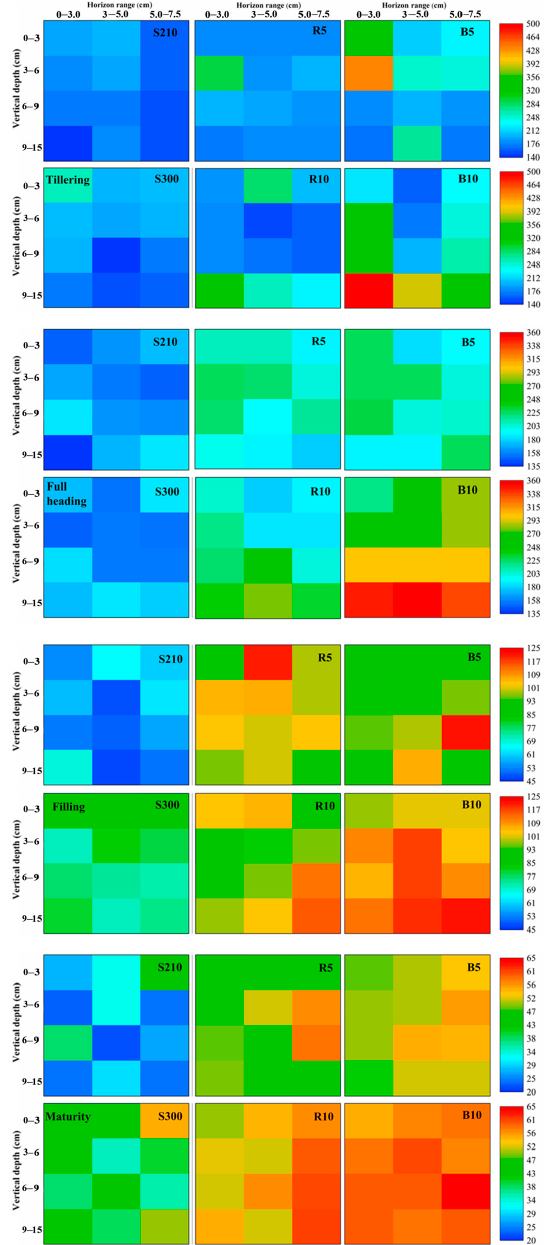
Figure 3. NH4 + -N content in different soil layers at tillering stage, full heading stage, filling stage and maturity stage (mg/kg). For deep treatment, the maximum soil NH 4+ -N concentration all appeared at tillering stage. At the same fertilization depth, NH 4+ -N at 5 cm depth concentrated in a 3–6 cm depth (vertical), 0–3 cm (horizontal) soil area, showing its highest concentration, R5 treat-